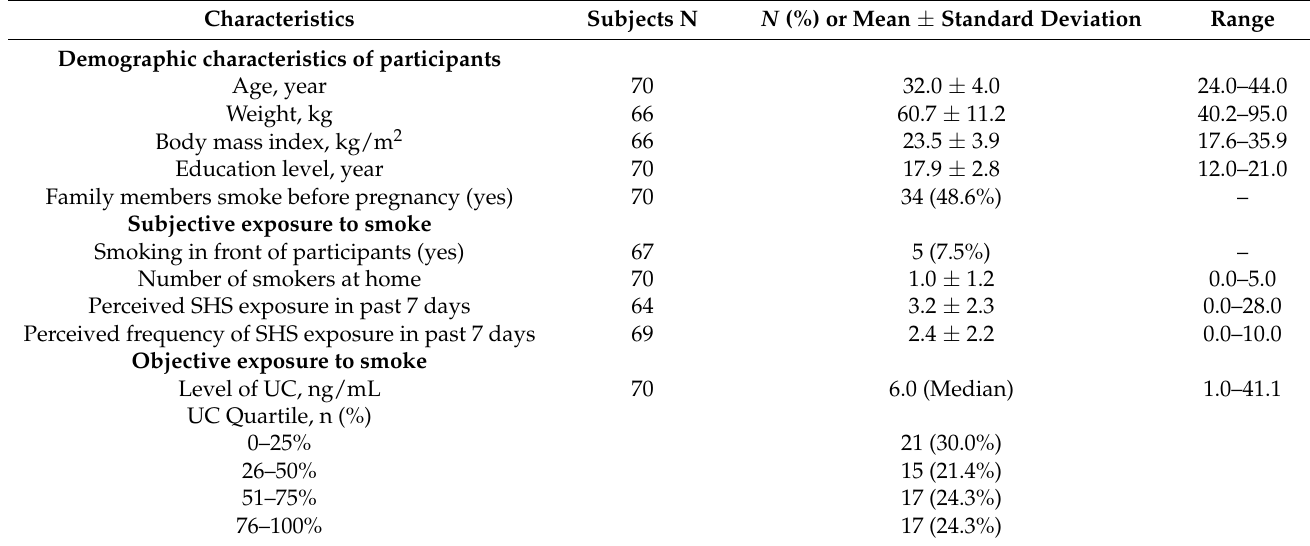
Table 1. Characteristics of pregnant women in this study ( N = 70).